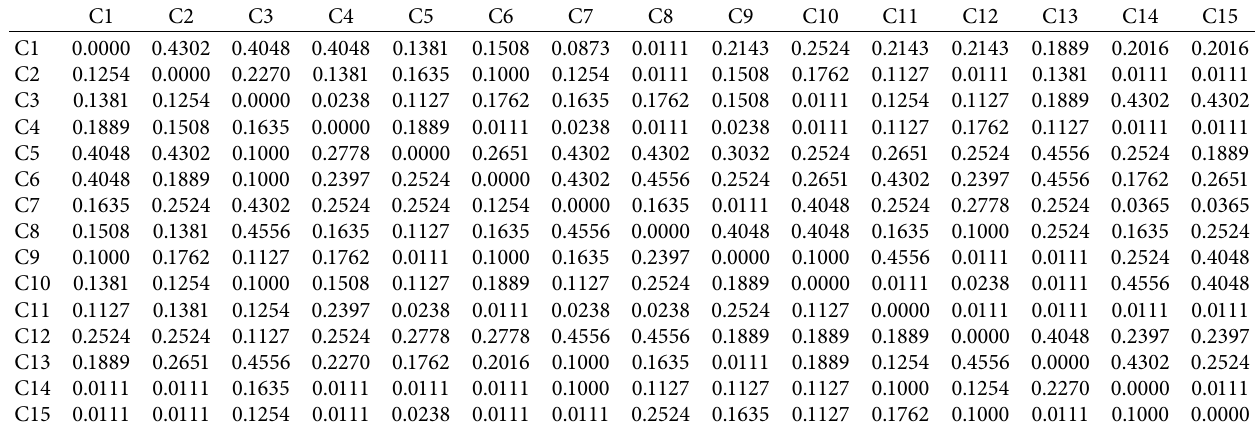
Table 3: The direct influence matrix of blockchain technology on intelligent transportation.